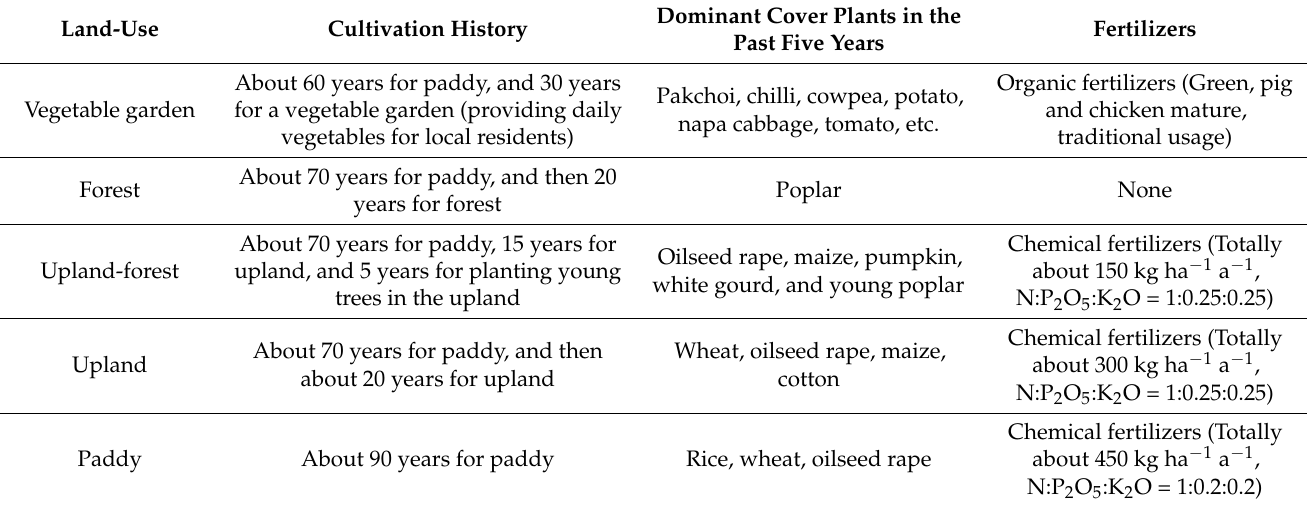
Table 1. The description of the land-use types in the selected study